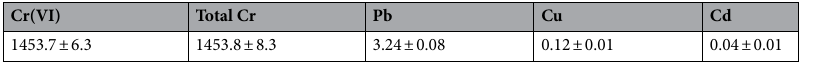
health, and its cost is also lower. Therefore, Cu/Fe bimetallic nanoparticles show a strong application prospect in water treatment 27,28 . Recent studies have pointed out that (1) catalytic metals can enhance the oxidation of nZVI during the interaction with pollutants through the formation of galvanic cells; (2) catalytic metals can facilitate the generation of activated atomic hydrogens which lead to the enhancement of reduction of pollutants and corrosion of nZVI 29–31 . Therefore, to better understand the removal performance and mechanism of Cu/Fe bimetallic nanoparticles, the removal of Cr(VI) by Cu/Fe bimetallic nanoparticles was investigated in this study. Cu/Fe bimetallic nanoparticles were prepared by chemical reduction in aqueous solutions and their reactiv- ity towards Cr(VI) in wastewater was examined. The main aims of this study were to (1) investigate the Cr(VI) removal efficiency by bimetallic nanoparticles at different experiment conditions; (2) clarify the removal mecha- nism of Cr(VI) by Cu/Fe bimetallic nanoparticles. Results of this study could provide a theoretical basis for the application of iron-based nanomaterials in environmental remediation.